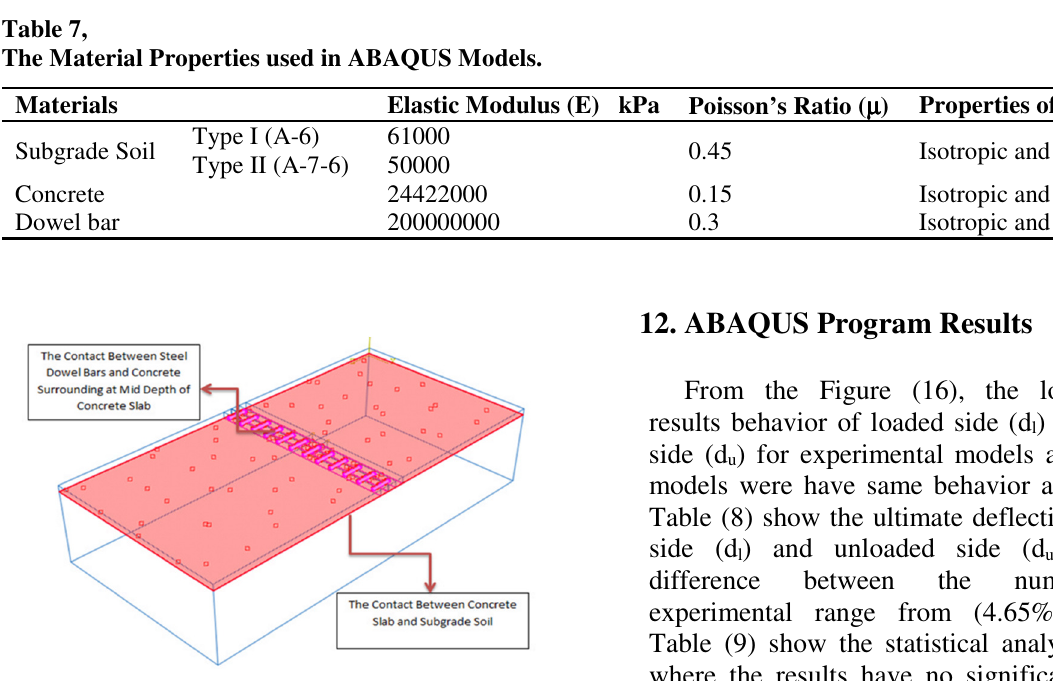
Fig. 14. The Contacts used in the Models.